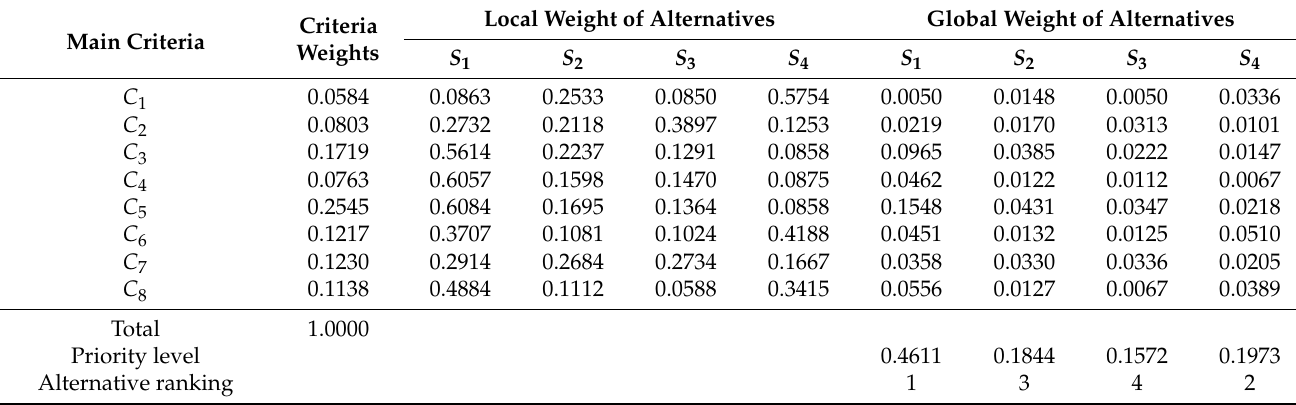
Table 3. Overall weights of sustainability criteria and